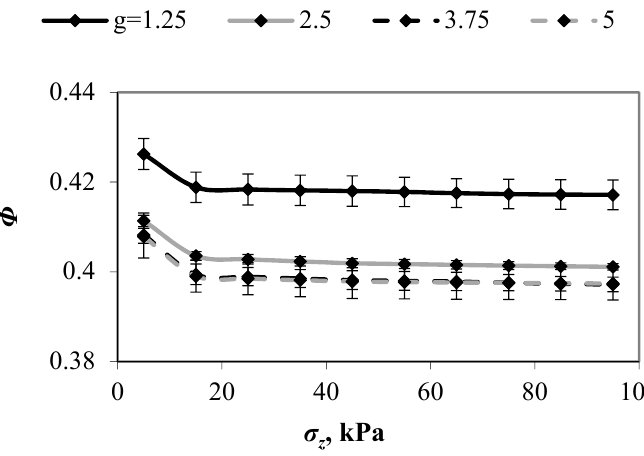
Figure2. Evolutionofporosityofmixtureswithvariousvaluesof g Figure 2. Evolution of porosity of mixtures with various values of g with imposed compressive pressures.